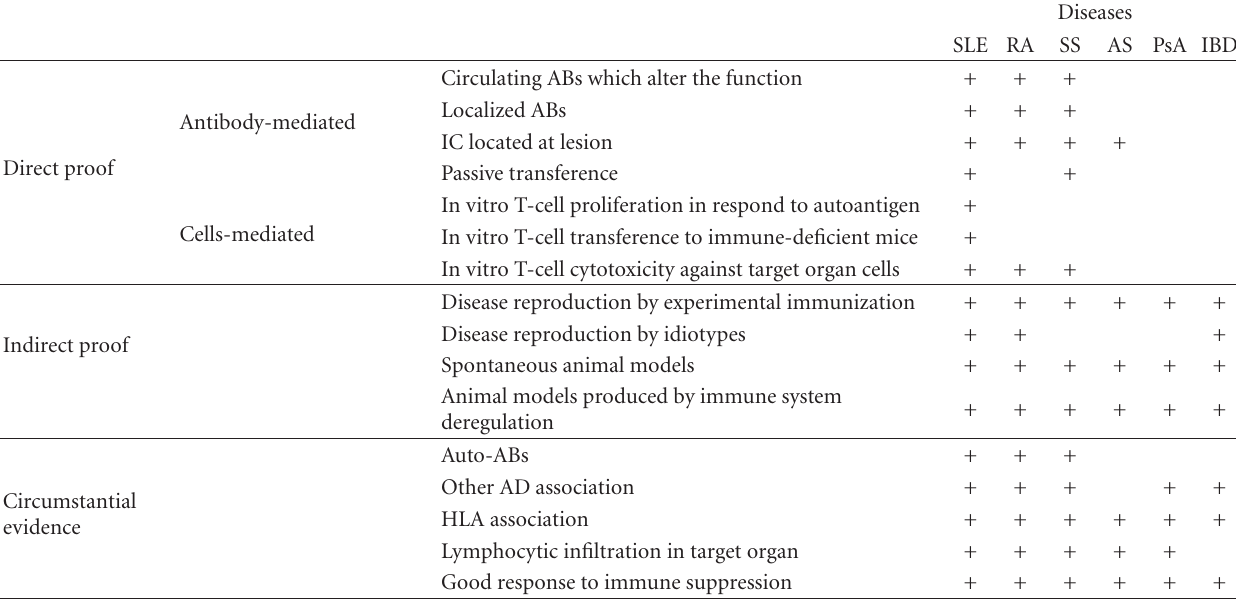
Table 1: Classification criteria for autoimmune diseases in humans. Comparison between ADs and autoinflammatory